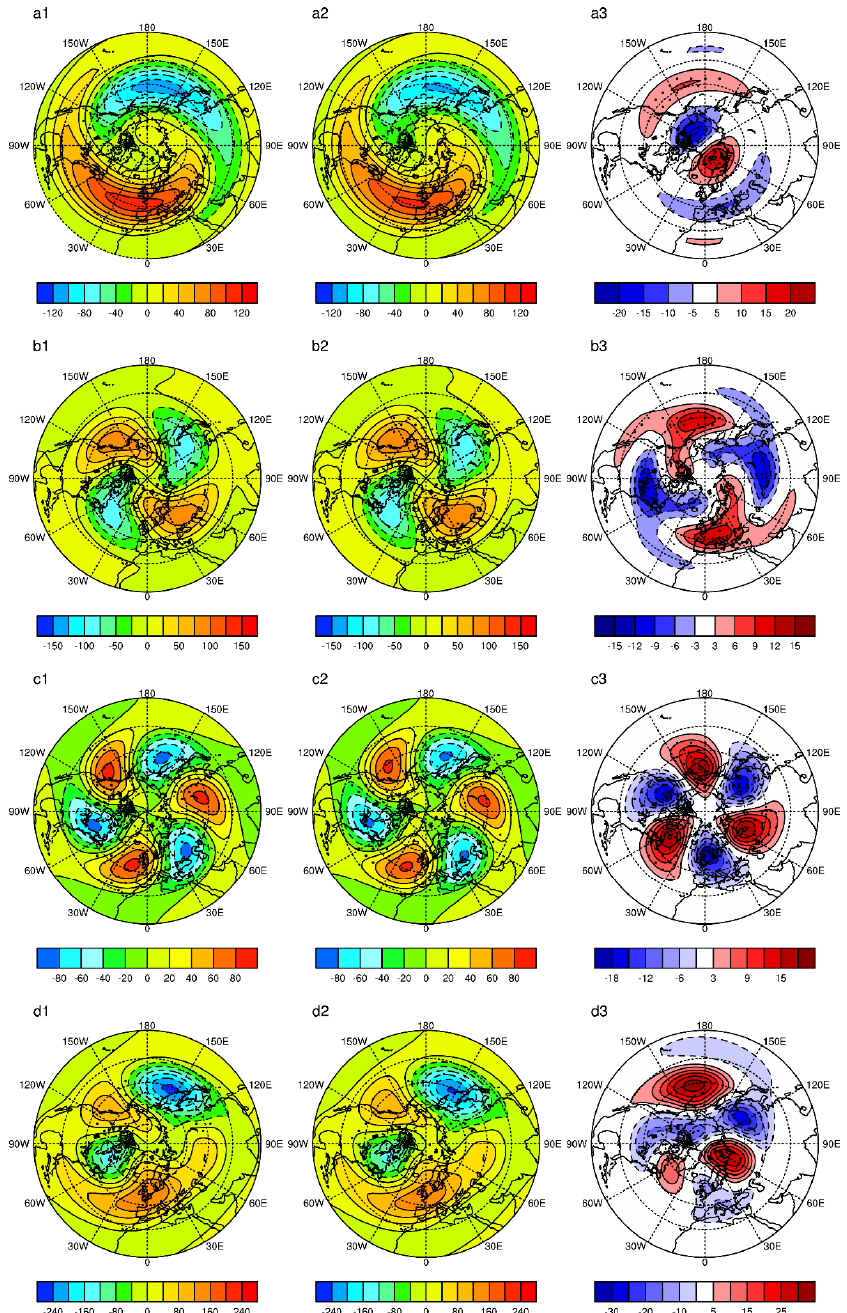
Figure 5. The distribution of 1 wave ( a1,a2 ), 2 wave ( b1,b2 ), 3 wave ( c1,c2 ), 1–3 wave ( d1,d2 ) and differences (P2–P1, a3,b3,c3,d3 ) on 500 hPa in two periods. (Units: gpm, and the dotted areas represent that the differences pass the significance test of 95%. The outermost latitude is 15 ° N.)